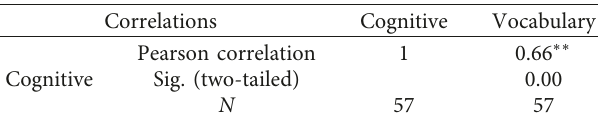
Table 7: The relationship between vocabulary knowledge and cognitive strategy